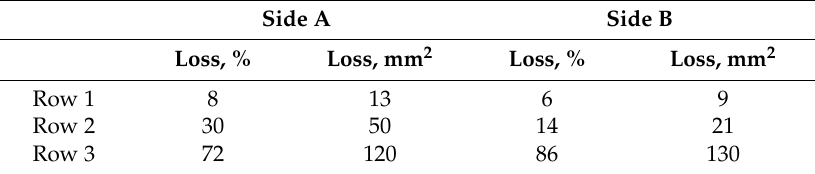
Table 2. Loss of material on the threshold cross-section of the first, third, and fifth rows. Side A Side B